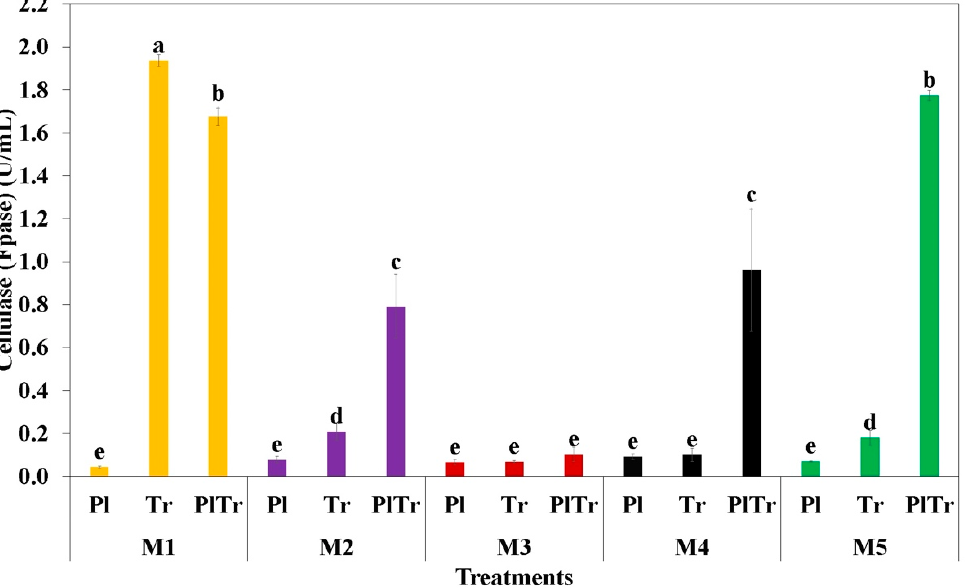
Figure 4. Enzymatic activities of cellulases (FPase) obtained in submerged fermentation using modified Mandels & Weber medium, with oil palm decanter cake (OPDC), wheat bran (WB), and cottonseed cake (CSC) as the carbon source. The media (M) composition is described in Table 2. Legends: P. lecomtei monoculture (Pl), T. reesei monoculture (Tr) and P. lecomtei + T. reesei co-culture (PlTr). Different letters over the bars mean significant differences ( p < 0.05) according to the Tukey test.